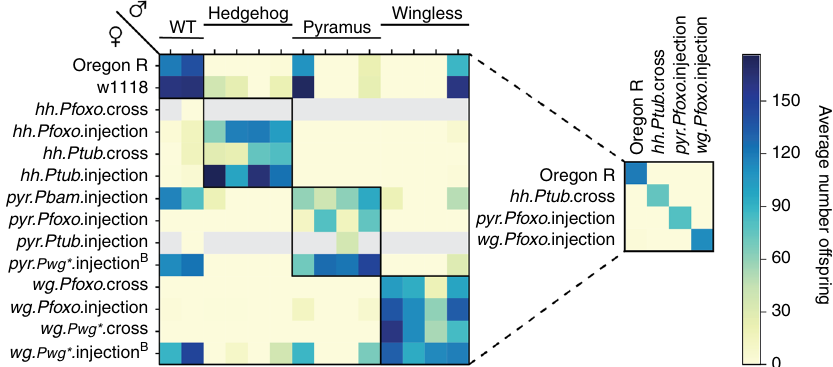
Fig. 4 Engineering multiple orthogonal EGI strains. Mating compatibility between wild-type and 12 EGI genotypes, reported as the number of adult offspring 15 days after mating. Female (maternal) genotype is listed on the left axis with the naming convention [target.PTApromoter.construction- method], and male (paternal) genotypes are presented in the same order along the top axis. Predicted compatible strains are indicated with black-outline boxes across the diagonal. Gray boxes indicate crosses that were not measured for lack of virgin females for hh.Pfoxo .injection and pyr.Ptub .injection strains. Superscript B denotes that the strain was later found to have fl oating Balancer chromosomes. Smaller grid at right highlights four mutually compatible strains. Unless otherwise noted in Source Data File, values represent mean of three